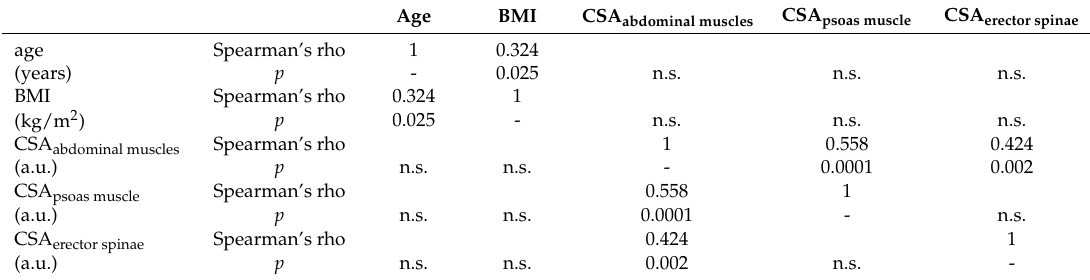
Table 5. This table illustrates the results of the correlation of age, body mass index (BMI), and cross-sectional area (CSA) in the abdominal muscles, psoas muscle, and erector spinae in women.